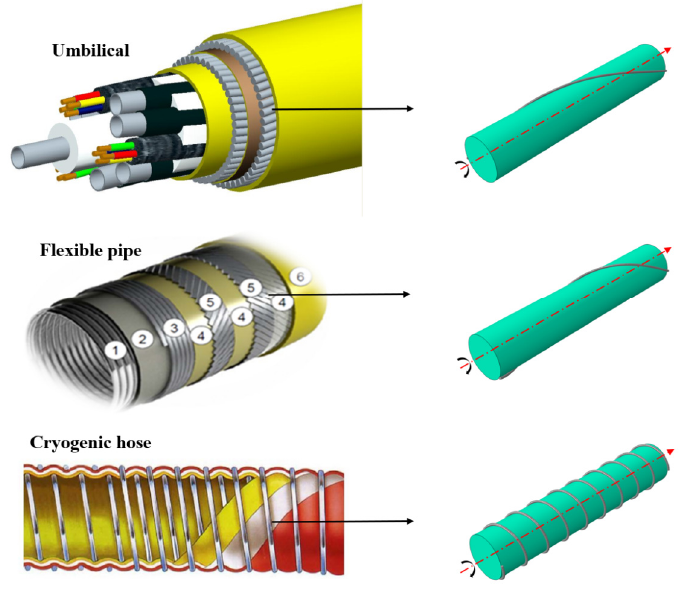
Figure 1. Structural characteristics of the marine flexible pipe/cables armoring layer.